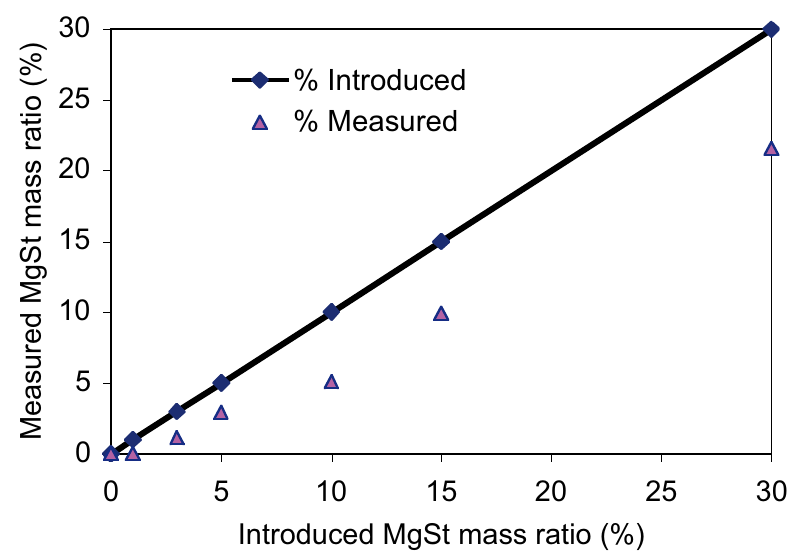
after the coating process calculates from the mass 2